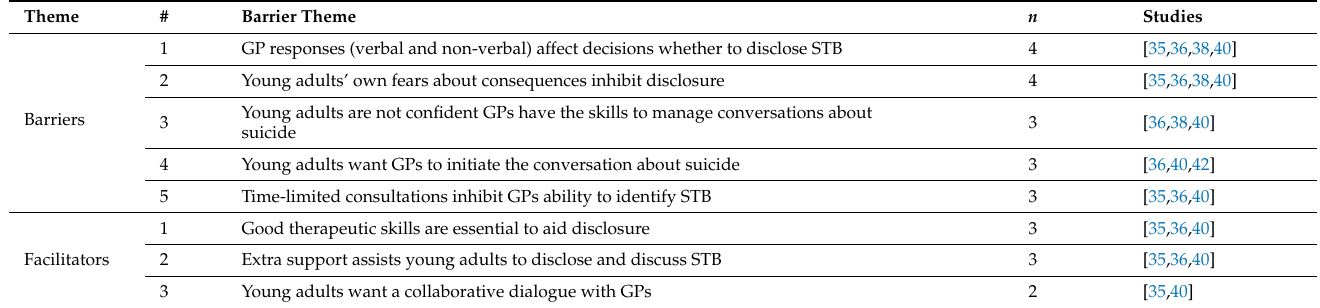
Table 3. Young adults: Key barrier and facilitator themes ( n =